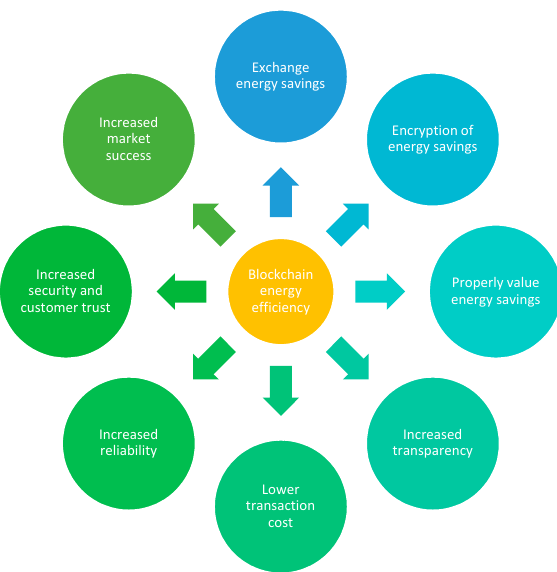
Figure 3. Benefits of blockchain in the energy efficiency sector.